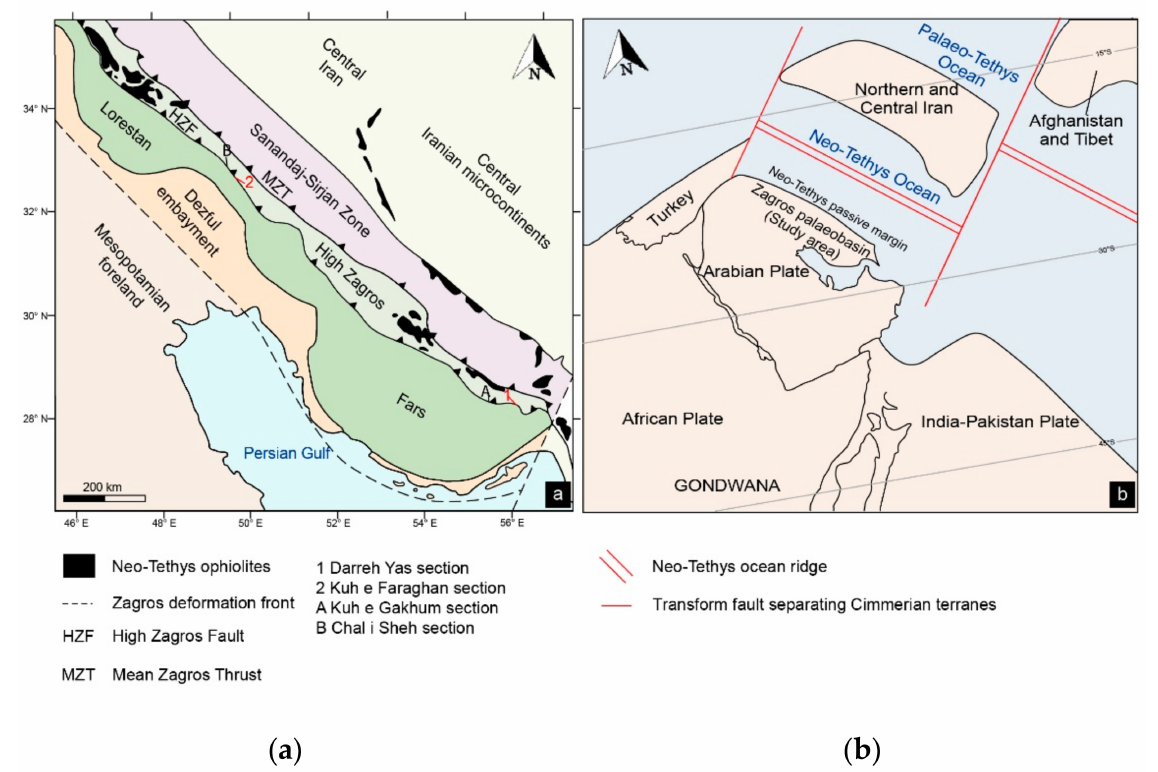
Figure 1. ( a ) Structural map of the Zagros range (modified and redrawn from [78]) and location of the studied and mentioned sections; ( b ) Paleogeographic map of the northeastern Gondwana margin (southern Pangea) during the Guadalupian age (drawn based on paleogeographic reconstructions of